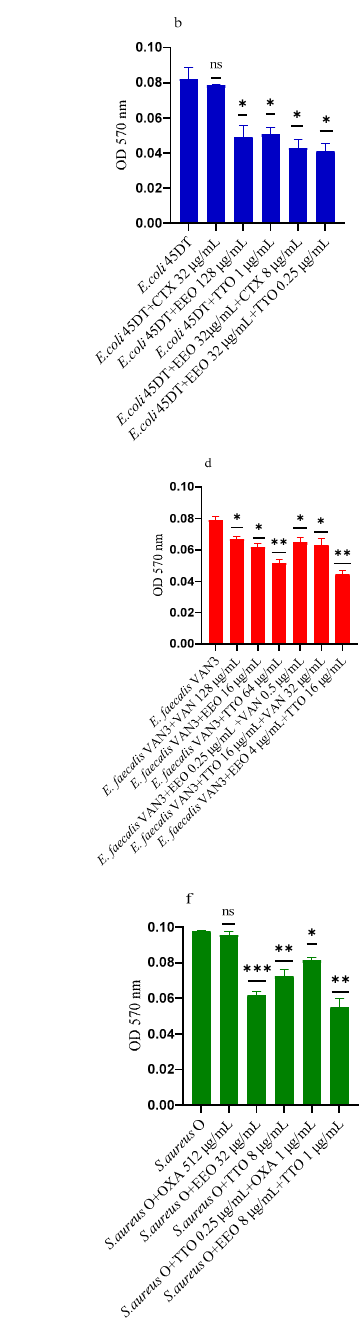
Figure 4. Quantification of viable cells in multi-species biofilm formation using Melaleuca alternifoli a (TTO), Eucalyptus globulus (EEO) EOs and the association EEO/TTO. Results were expressed in Log CFU/mL as the arithmetic mean of the three determinations. p -values of <0.05 (*), p < 0.01 (**), p < 0.001 (***) and p < 0.0001 (****) were considered significant by ANOVA test.